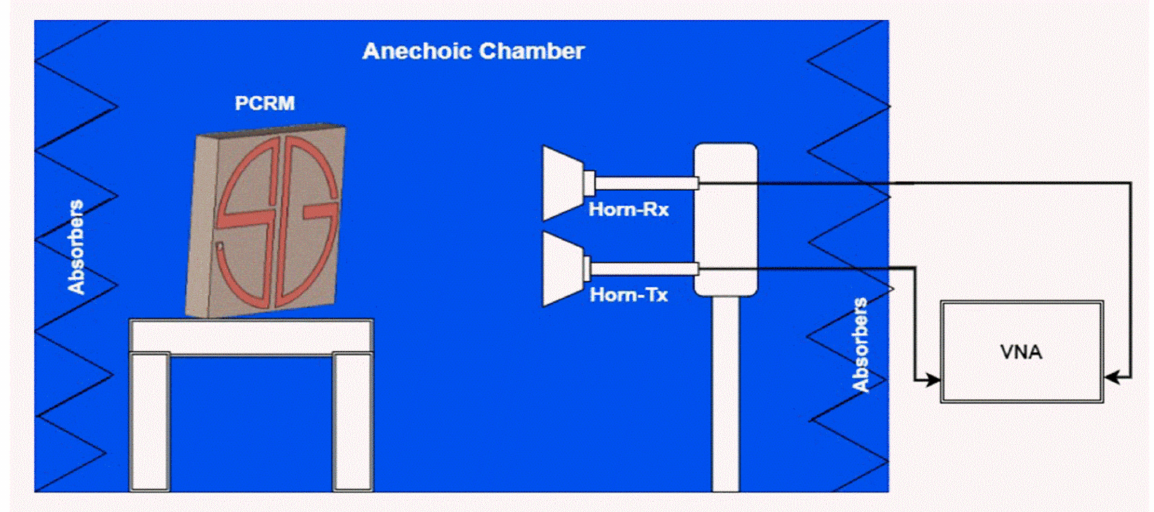
Figure 13. Schematic of the measurement